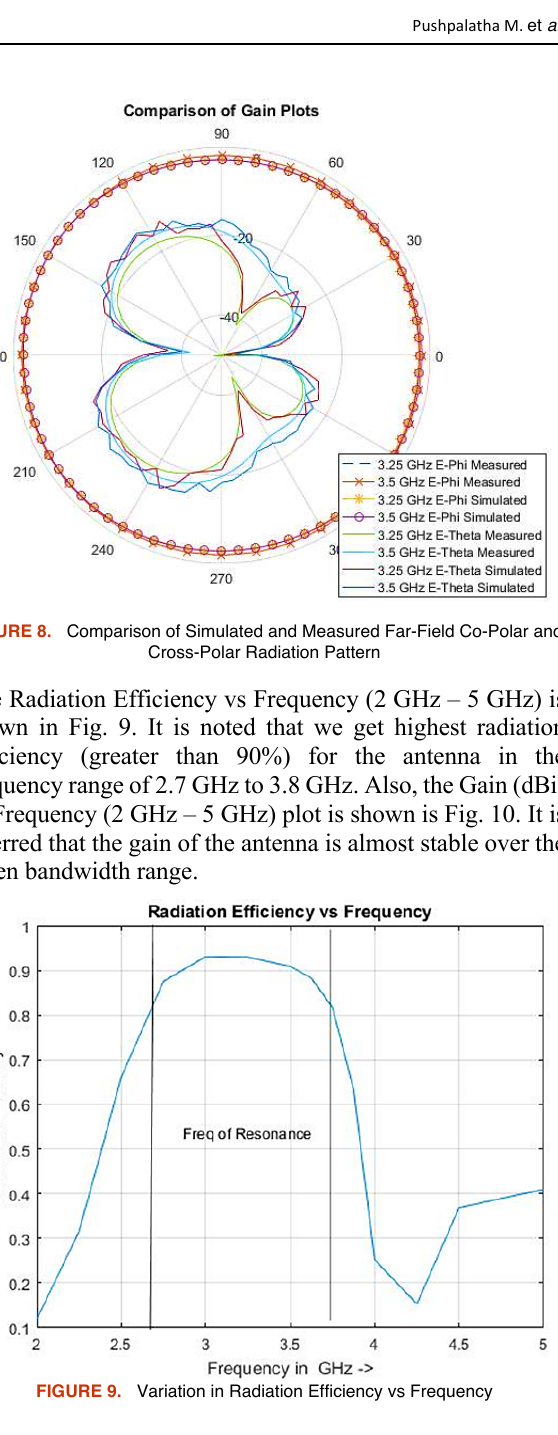
FIGURE 9. Variation in Radiation Efficiency vs